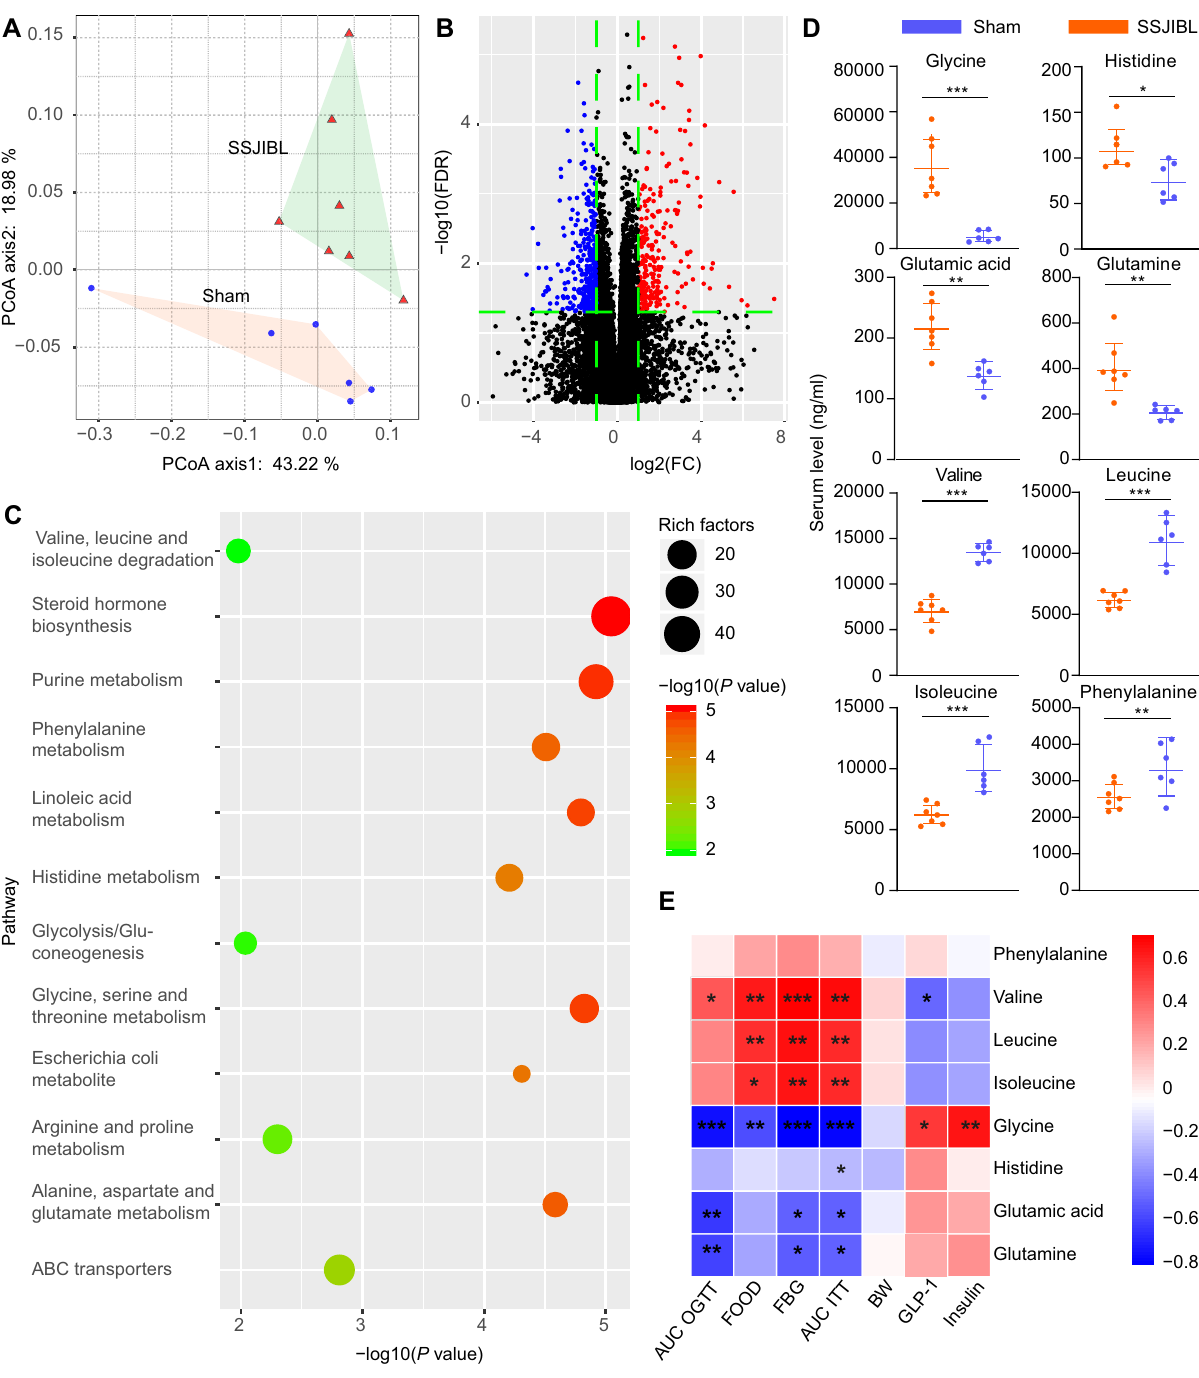
Figure 6. SSJIBL alters amino acids metabolism in GK rats 6 weeks postoperation. ( A ) PCoA analysis score plots for discriminating the fecal metabolome from SSJIBL and Sham groups. ( B ) Volcano map of different metabolites. ( C ) Disturbed metabolic pathways in the SSJIBL versus Sham groups. ( D ) Comparison of circulating levels of glycine, histidine, glutamic acid, glutamine, valine, leucine, isoleucine, and phenylalanine in serum by GC–MS in the indicated groups. ( E ) Heatmap analysis of the Pearson correlation of serum amino acids and glucose homeostasis-related indexes. Red represents positive correlation, and blue indicates negative correlation. Error bars are expressed as means ± SEM. Statistical significance was determined by two-tailed Student’s t test. * P < 0.05, ** P < 0.01, *** P <